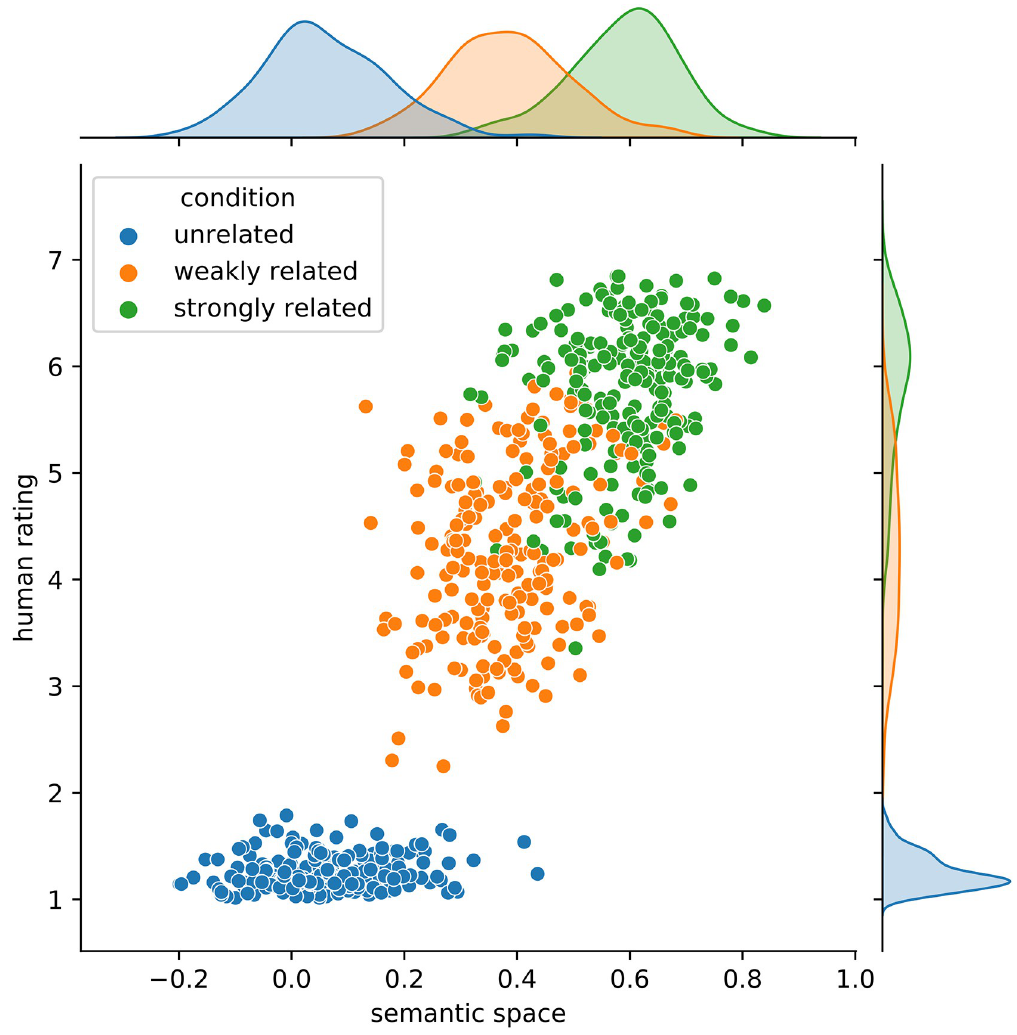
Fig 3. Scatterplot showing the relationship between the semantic space similarity estimates ( nkjp+wiki-lemmas- restricted-300-cbow-ns . txt . gz ,[11]) and the human similarity